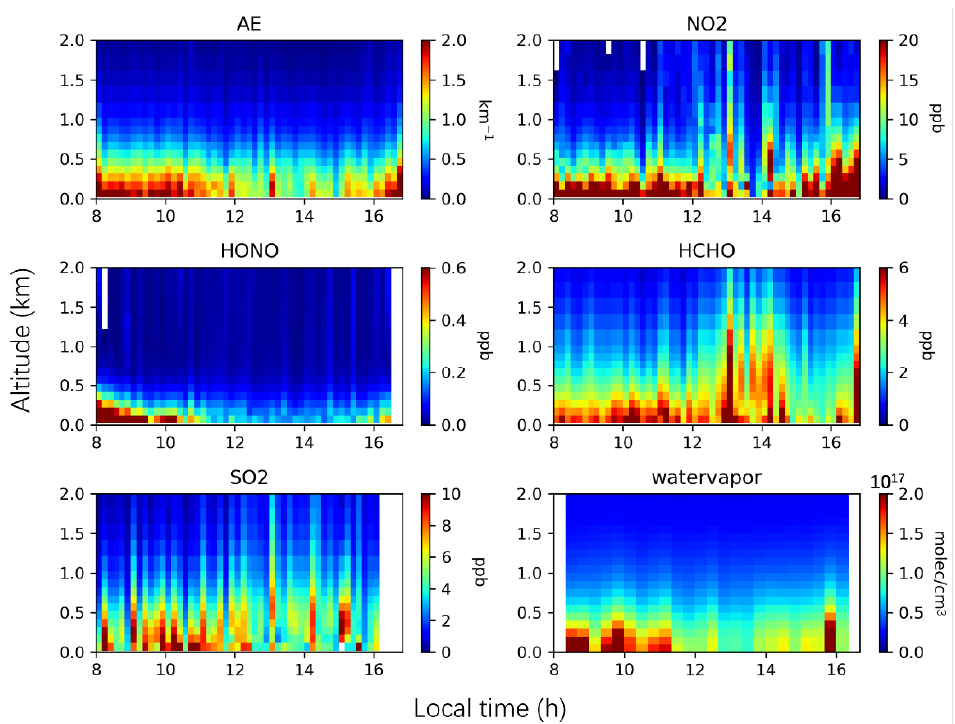
Figure 6. Diurnal variations of the vertical distribution characters of tropospheric aerosol extinction coefficient, and HONO, SO 2 , NO 2 , HCHO, and water vapor vertical mixing ratios during haze days.